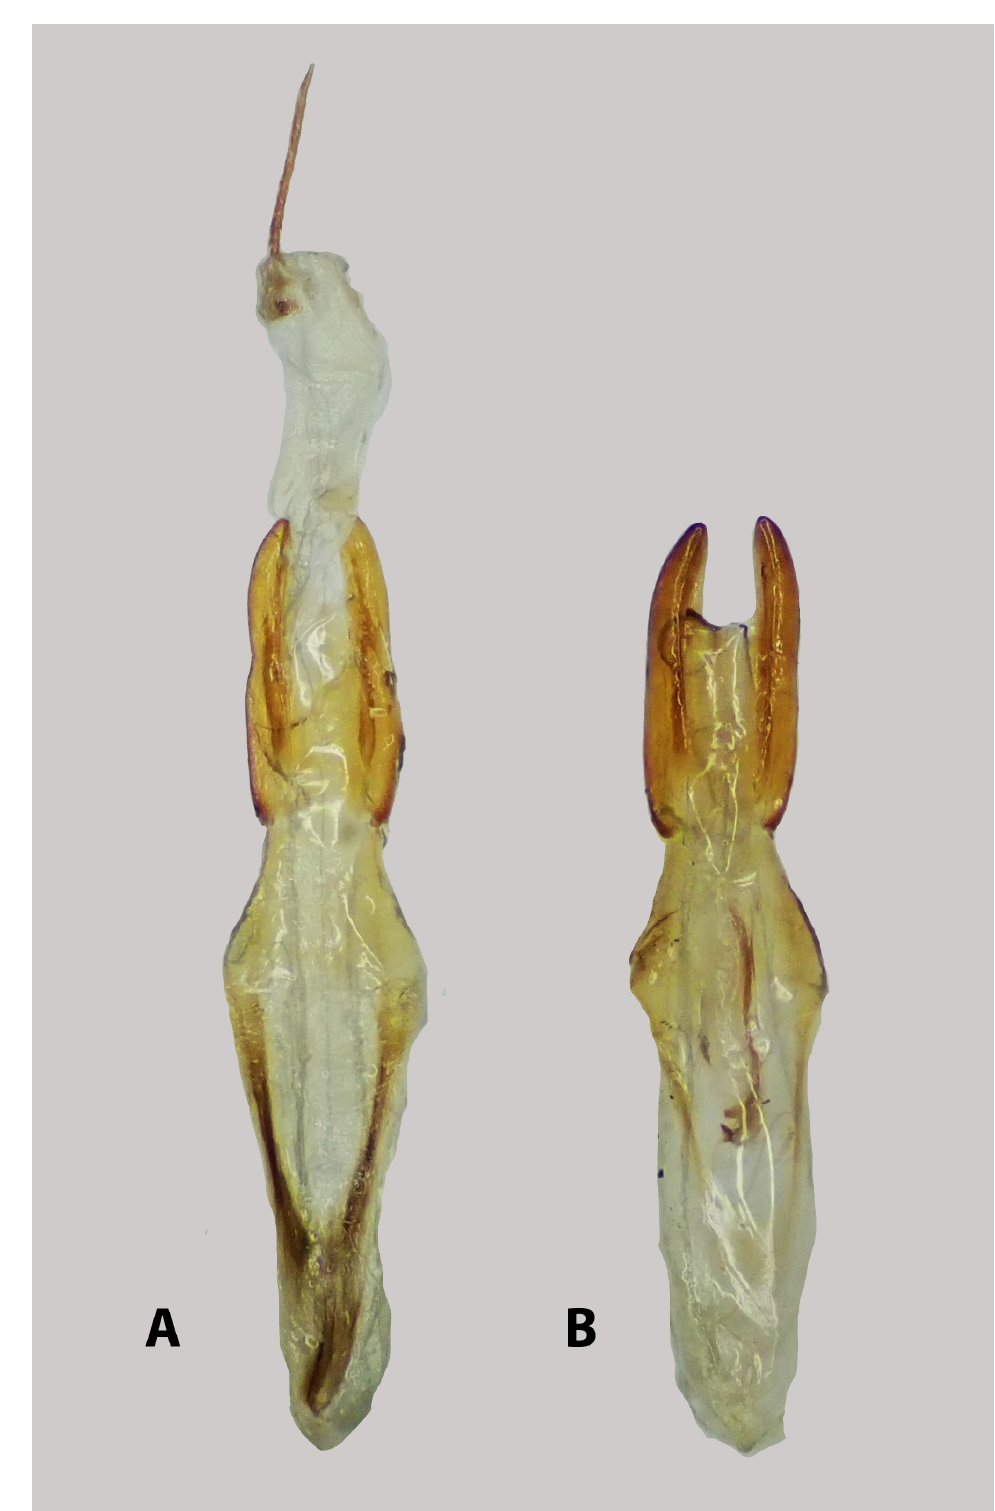
Fig. 8. Male genitalia of Pseudochelidura cantabrica Cuesta-Segura, Jurado-Angulo & García-París sp. nov. A . Phenotype III–IV from Puerto de Áliva (Cantabria, Spain) (ADC-S col. Derm_0008). B . Phenotype II from Puerto de Vegarada (León, Spain) (ADC-S col. Derm_0005). Photographs by